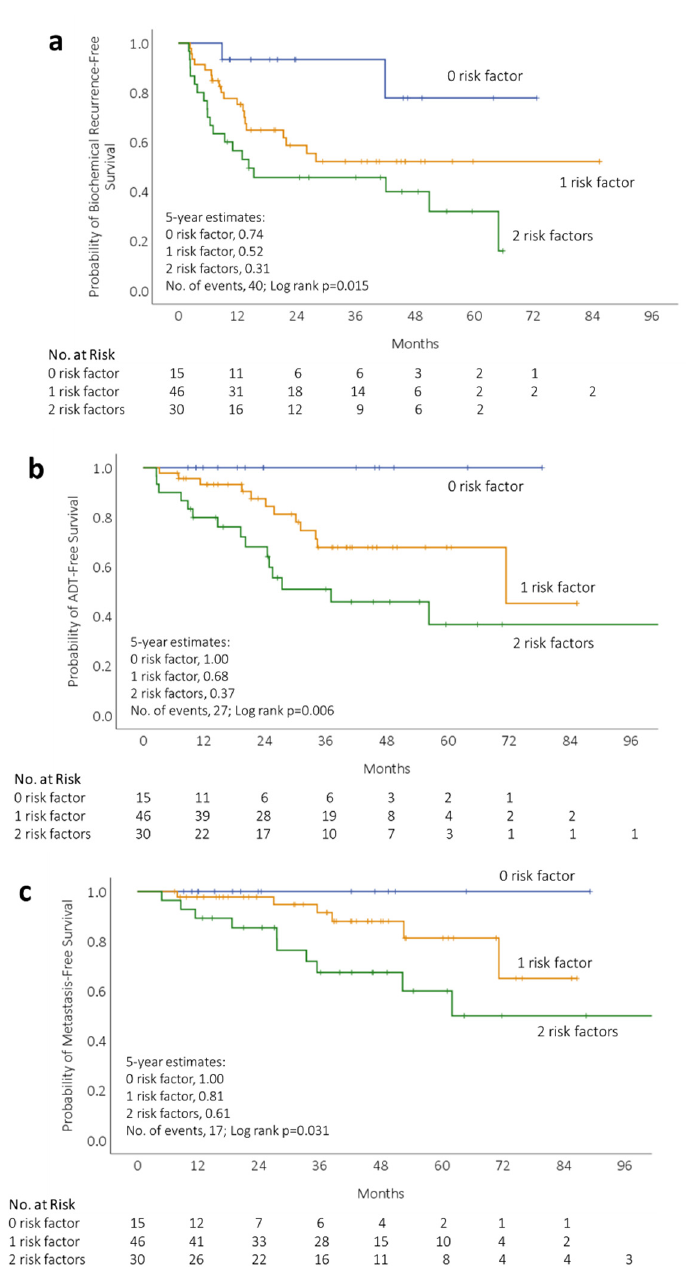
Figure 2. Kaplan–Meier survival curves depicting ( a ) biochemical recurrence-free, ( b ) ADT-free, and ( c ) metastasis-free survival after SRT in 91 patients stratified by risk factors into 0 risk factors (blue), 1 risk factor (orange), and 2 risk factors (green).